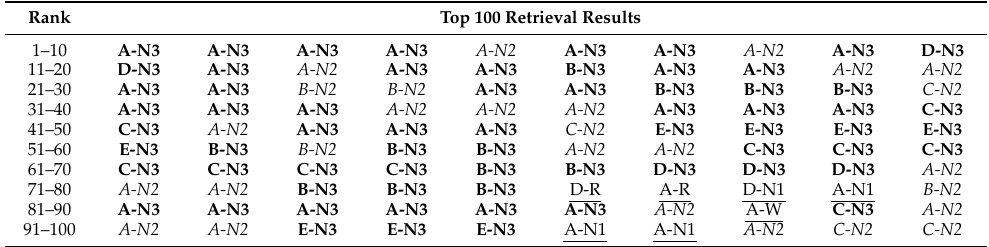
Table 5. Analysis of the retrieval results of an infrared sleep video (sleep stage of N3, hash code length of 64). We bold the results belonging to N3, italicise those belonging to N2 and underline the rest. Rank Top 100 Retrieval